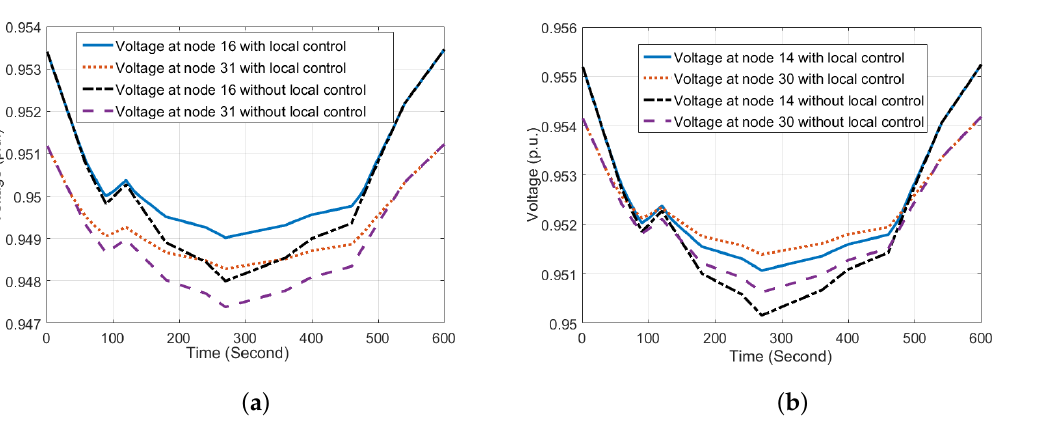
Figure 9. Comparison of the resulting voltage profiles with and without executing local control scheme for Case 3: ( a ) nodes 16 and 31 with PV systems/ESSs; ( b ) nodes 14 and 30 without PV